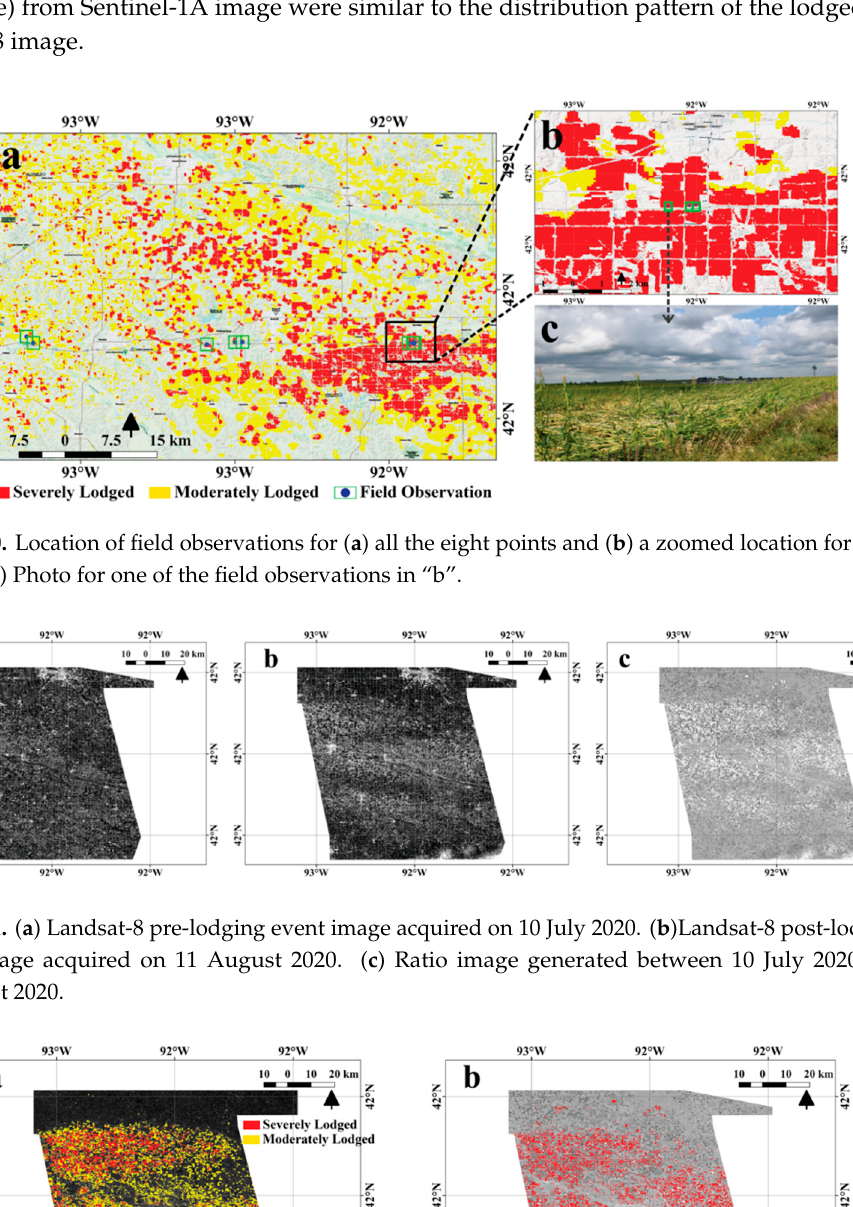
Figure 11. ( a ) Landsat-8 pre-lodging event image acquired on 10 July 2020. ( b )Landsat-8 post-lodging